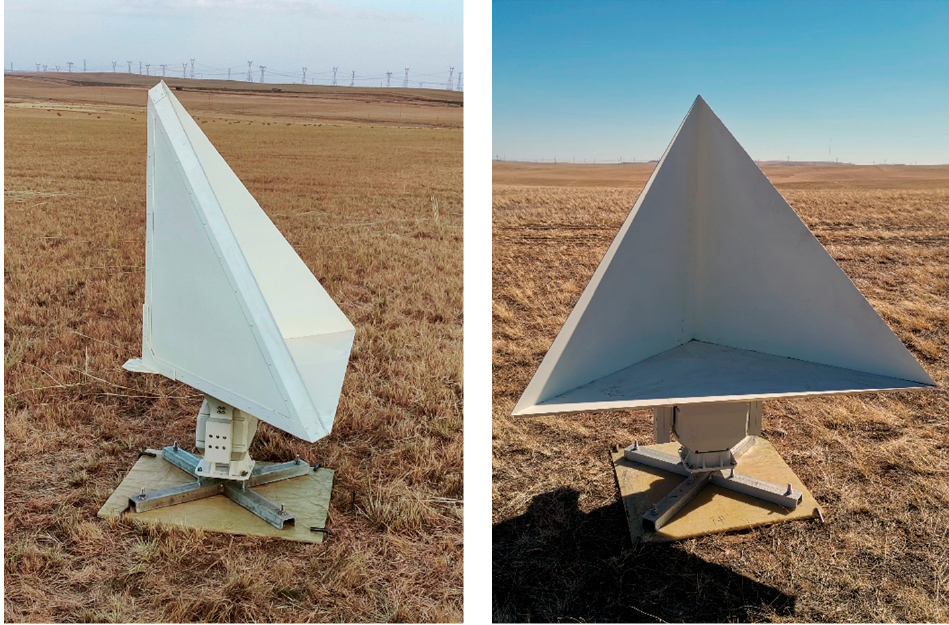
Figure 6. Automatic trihedral corner reflectors.